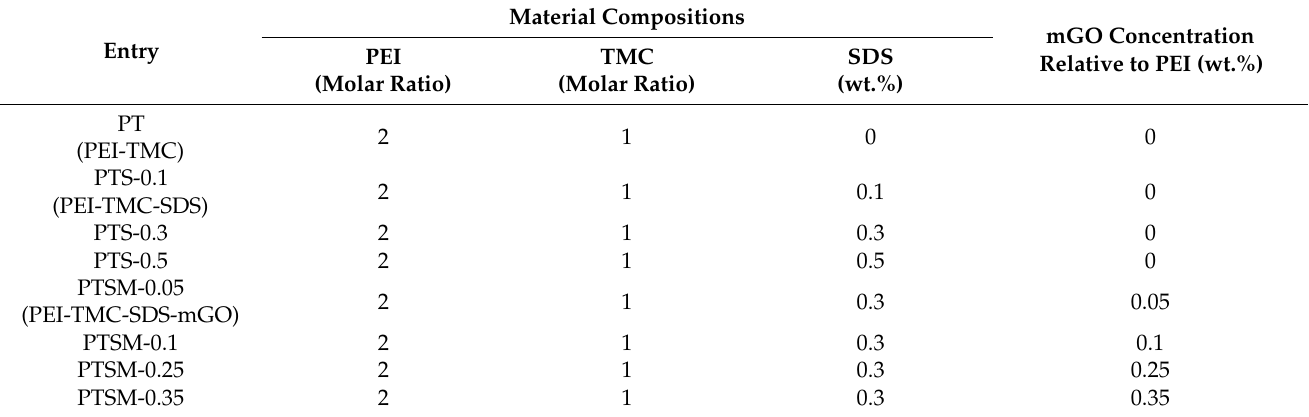
Table 2. Compositions of GO-thin-film composite hollow fiber